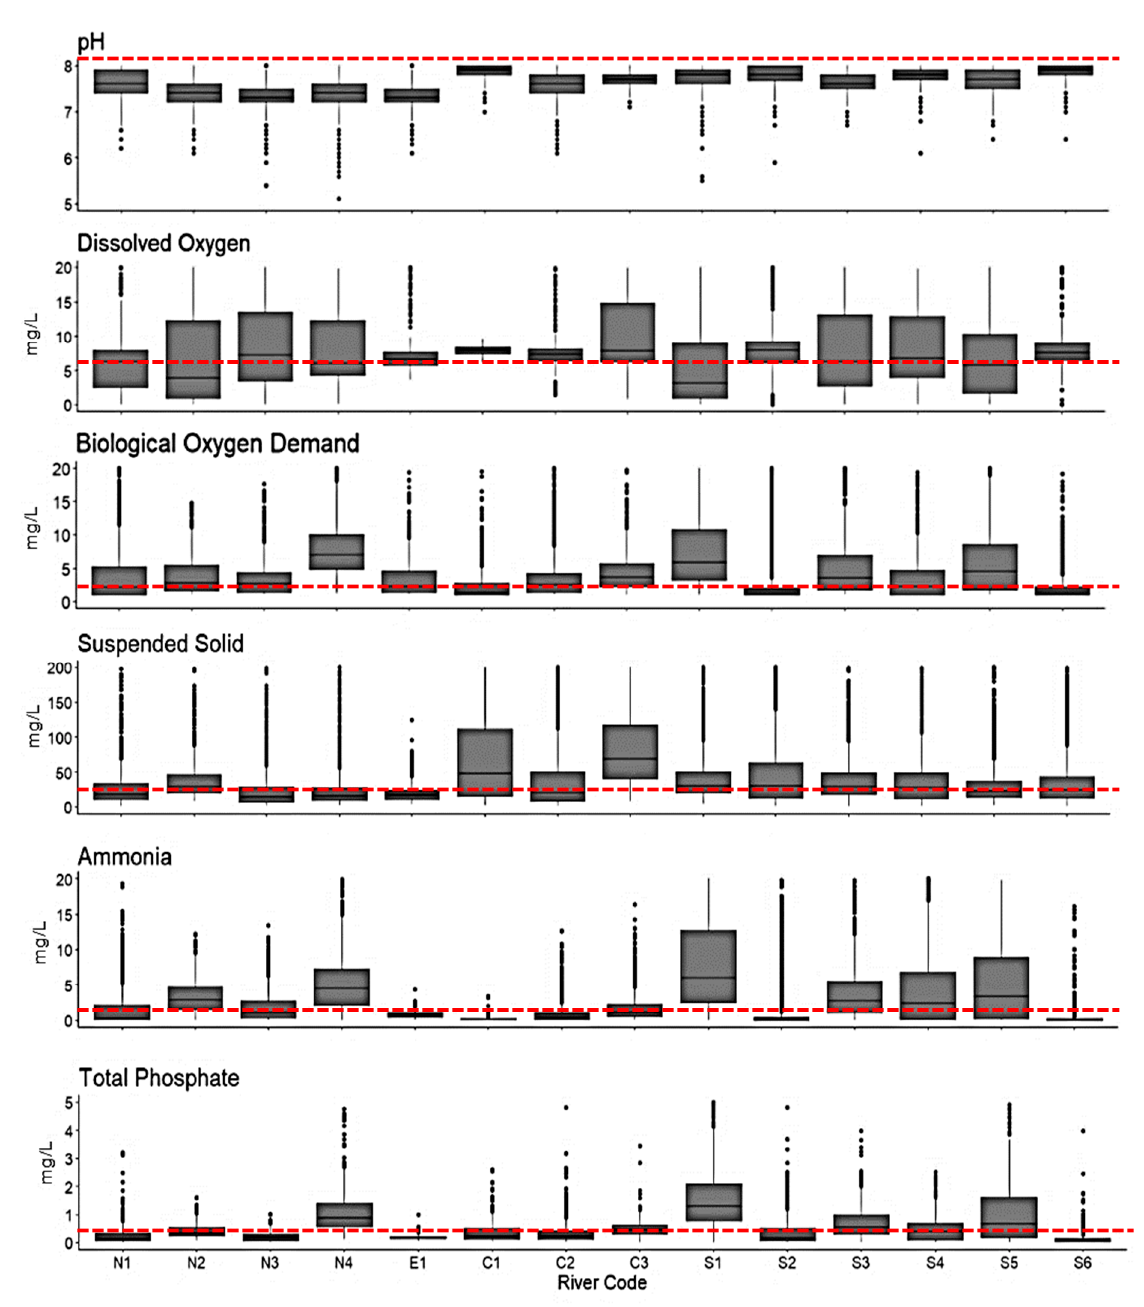
Figure 4. Boxplot of river water quality parameters for 14 representative rivers in Taiwan (see Table 1 for the river names associated with the river codes).